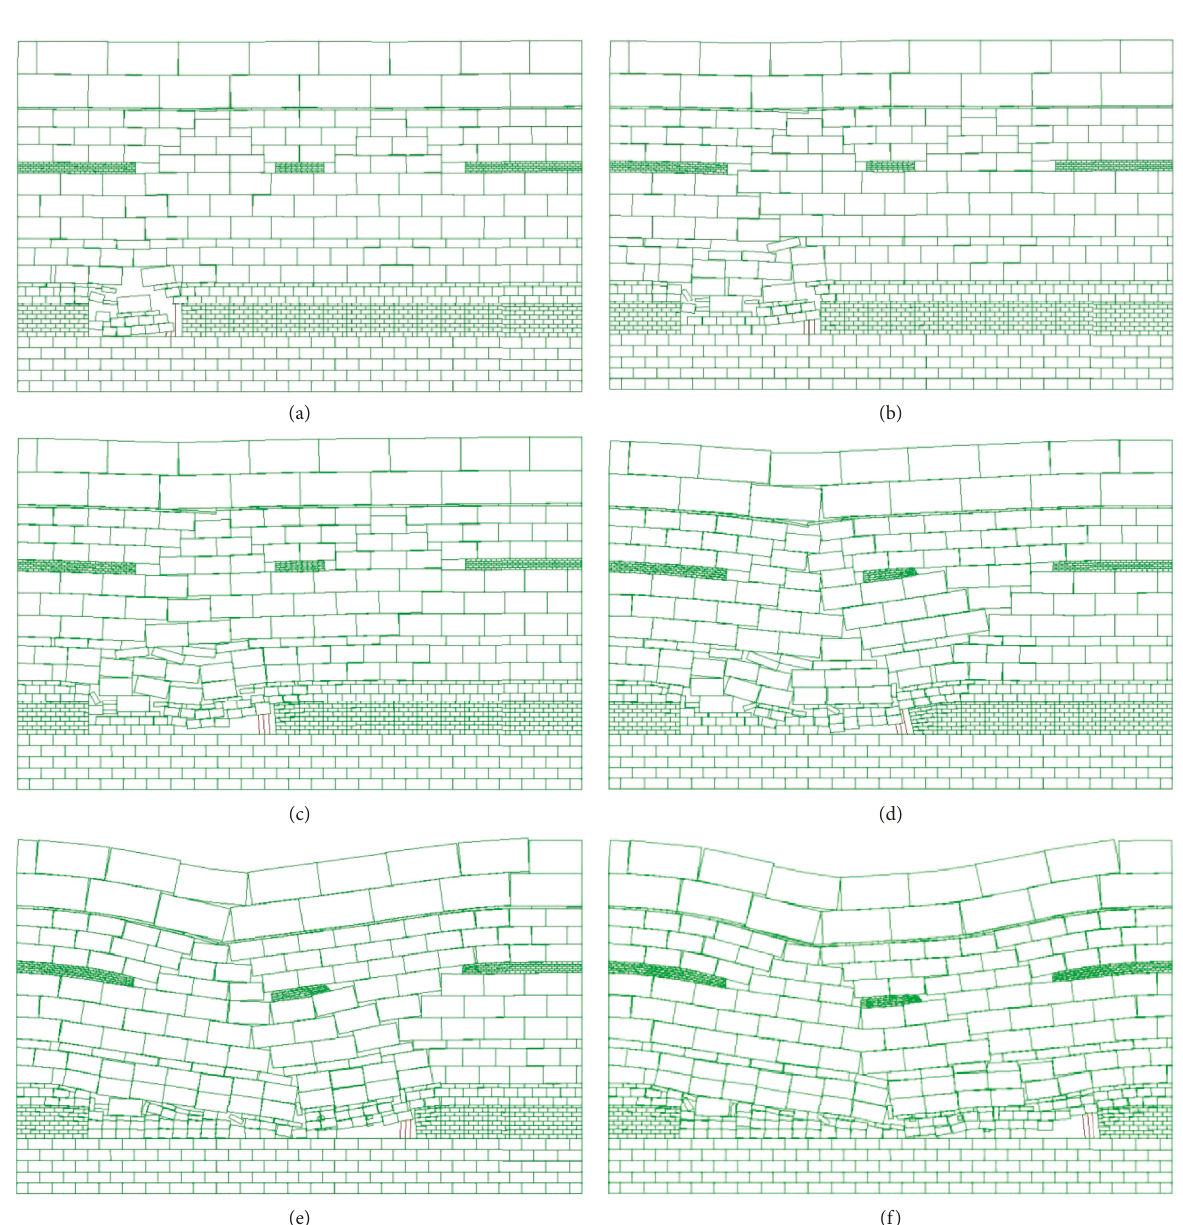
Figure 4: The evolution diagram of collapsing characteristics of overburden rock in the 60m interlayer. Advance of the working